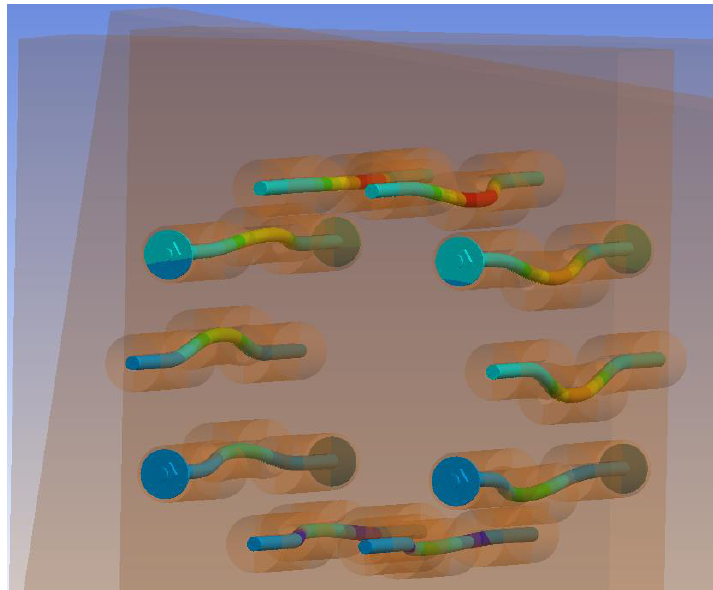
Figure 18. Overall deformation of fasteners (bolts and dowels) for Experiment A.